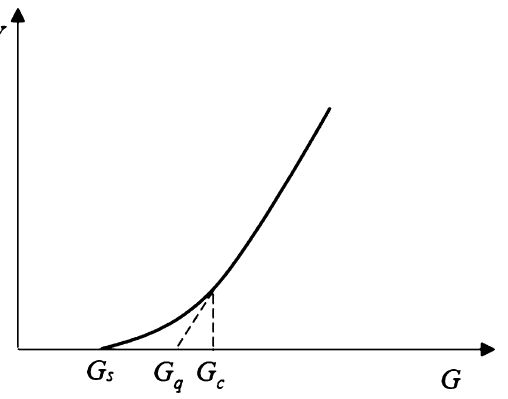
Fig. 7 Typical relation curves of seepage velocity and pressure gradient in